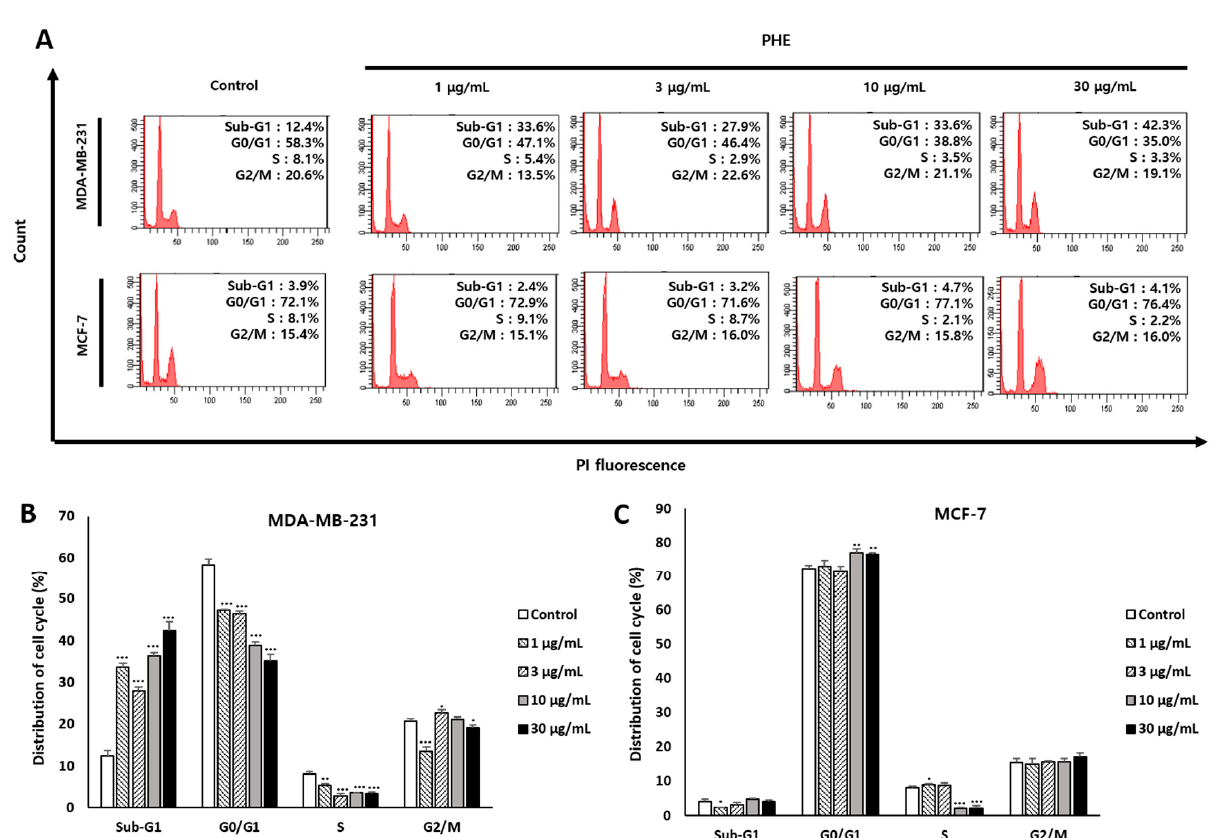
Figure 2. Physconia hokkaidensis methanol extract (PHE) induces the cell cycle arrest of MDA-MB-231 cells at the sub-G1 phase. ( A ) The cell cycle distribution of PHE-treated MDA-MB-231 and MCF-7 cells for 24 h. The cells were measured using a flow cytometer. ( B , C ) Statistical analysis of cell cycle distribution of PHE-treated MDA-MB-231 and MCF-7 cells. All data are expressed as mean ± SD of three independent experiments. * p < 0.05, ** p < 0.01, *** p < 0.001 compared to the control of each cell